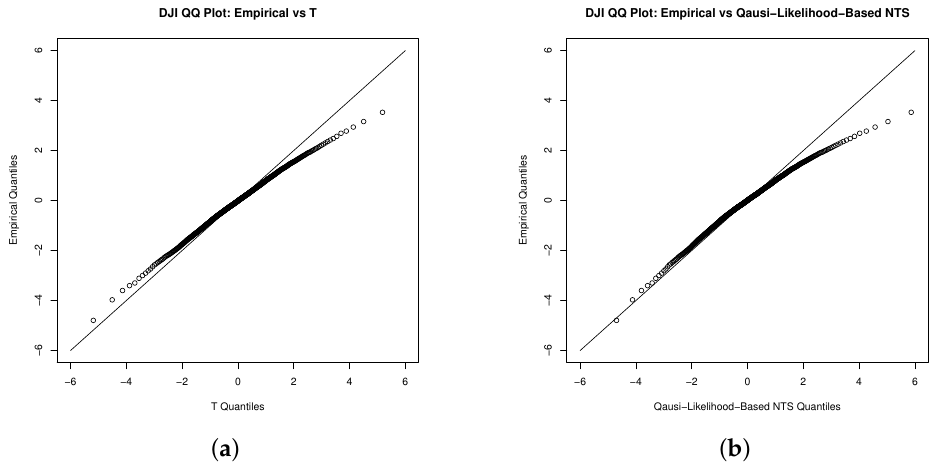
Figure 5. QQ plot for the innovations of Dow Jones index with ( a ) Student’s t and ( b ) NTS distribution.